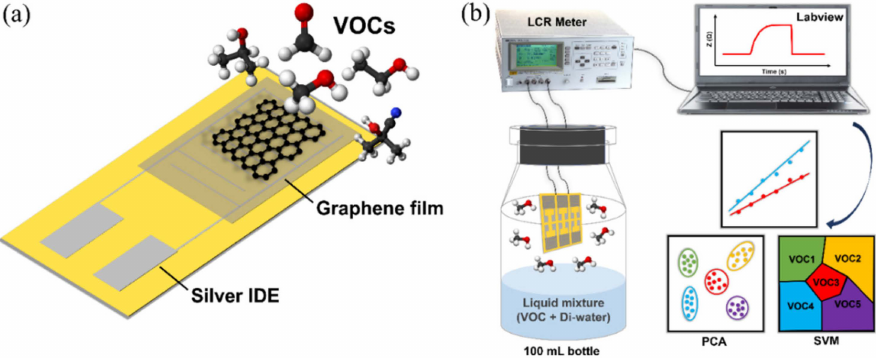
Figure 1. ( a ) Schematic representation of the proposed design of the graphene-based silver IDE sensor under target VOCs and ( b ) system overview of the impedimetric measurement setups and the corresponding signal